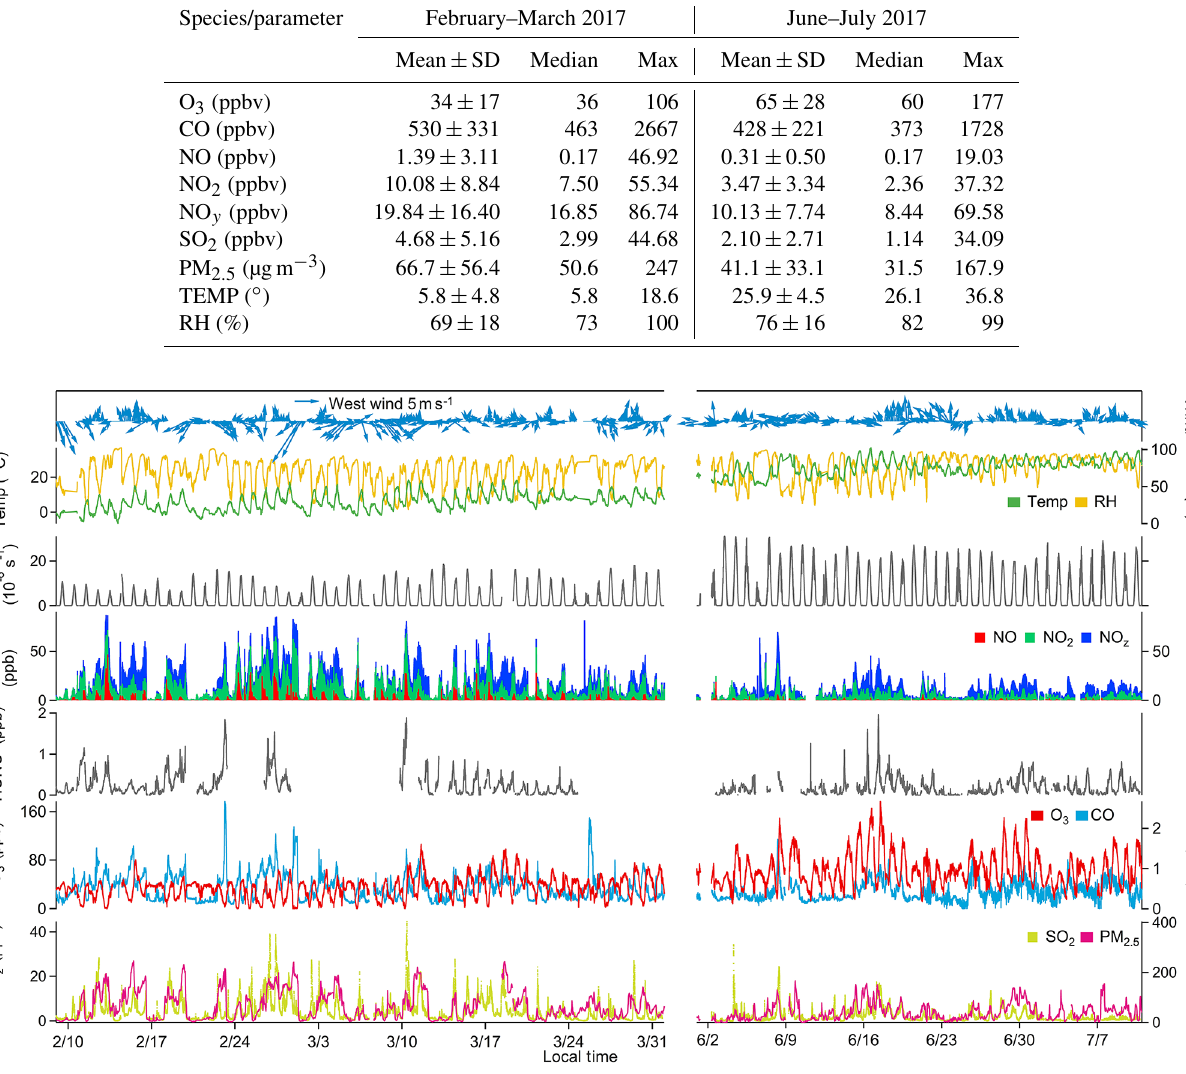
Figure 2. Time series of major trace gases, PM 2 . 5 , and meteorological parameters measured at the study site during February–March and June–July